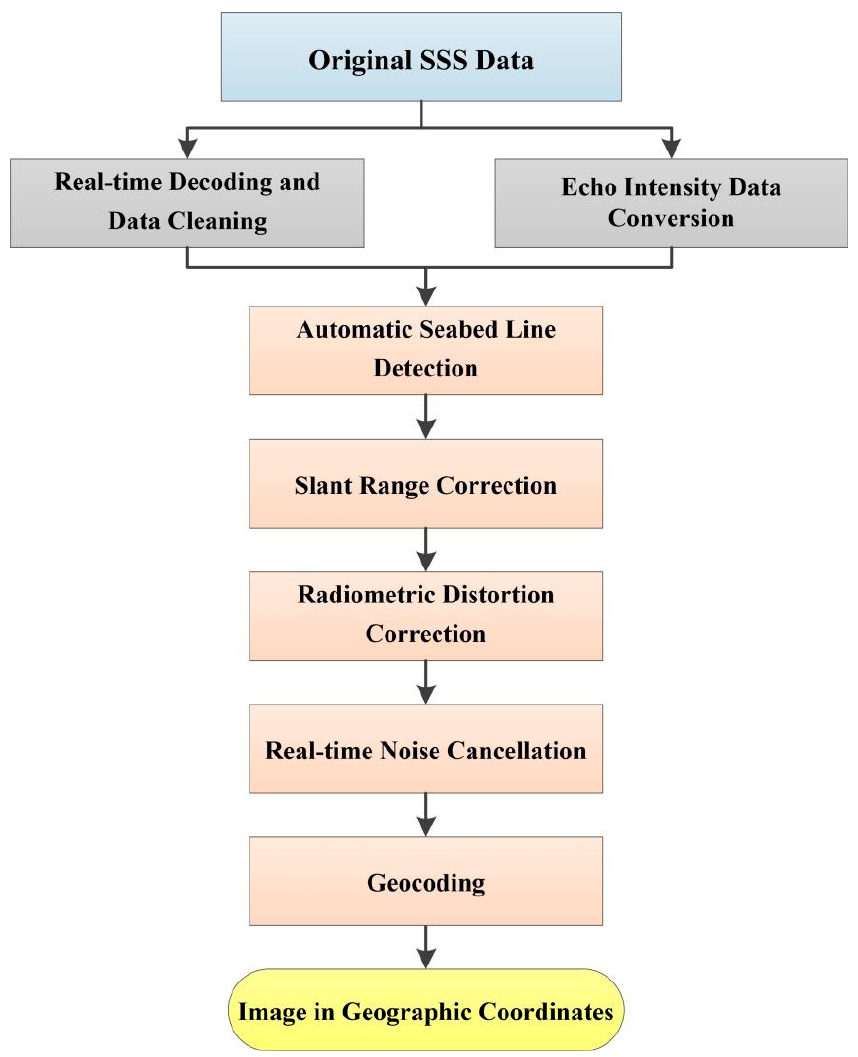
Figure 4. SSS data processing.